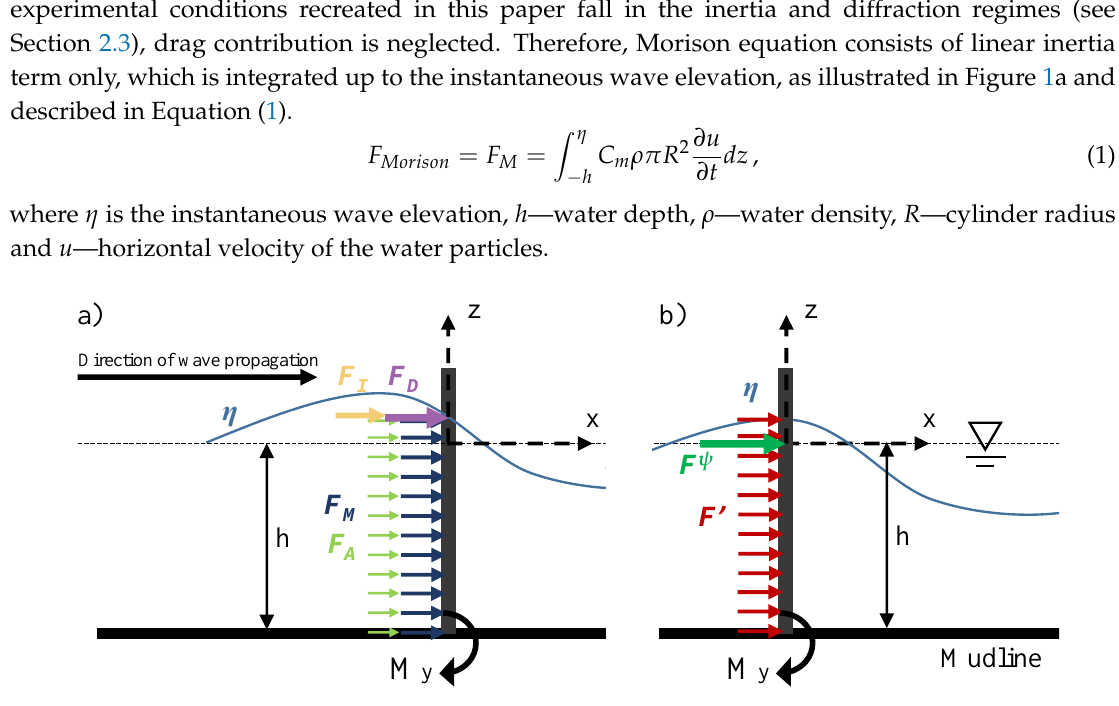
Figure 1. Coordinate system and the implemented hydrodynamic loading model components of: ( a ) Morison equation (integrated inertia term F M ) and Rainey theory (integrated terms F M + F A , and point loads at the instantaneous free surface F I + F D ); ( b ) FNV theory (integrated term F (cid:48) and point load at mean water level F ψ